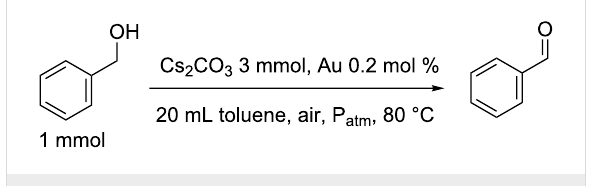
The increase in catalytic activity from (A) to (A 200 ) and the highest TOF (261 h − 1 ) in the case of (A 300 ), is explained by